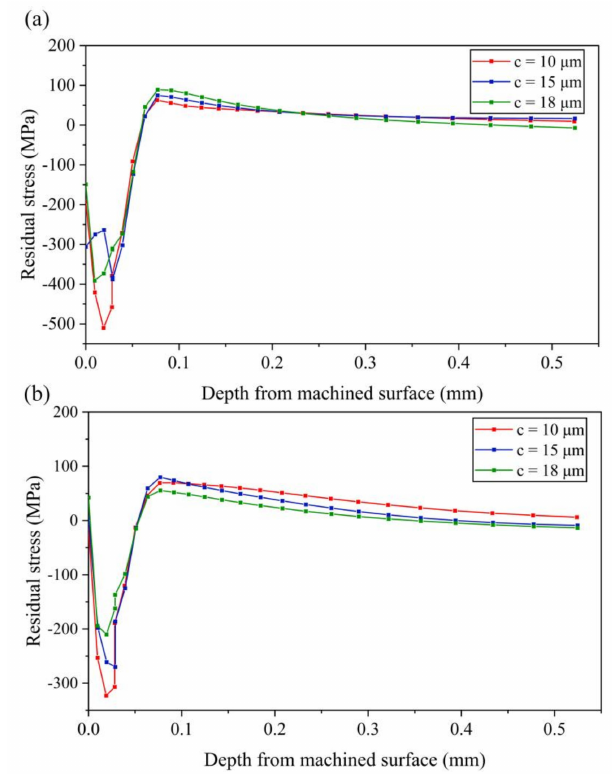
Figure 15. Results of residual stress with various amplitudes c ( a ) stress-xx ( b )